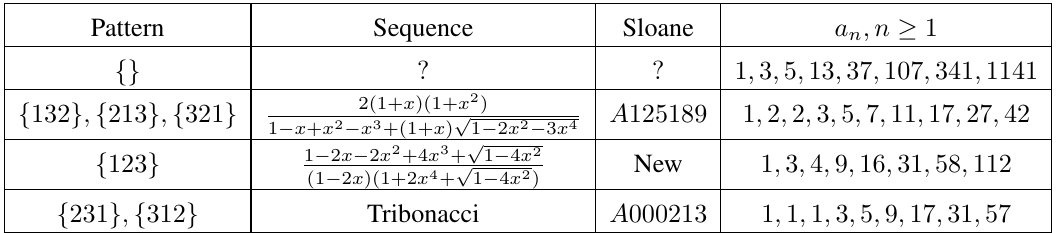
Tab. 4: Irreducible involutions avoiding at most one pattern of S 3